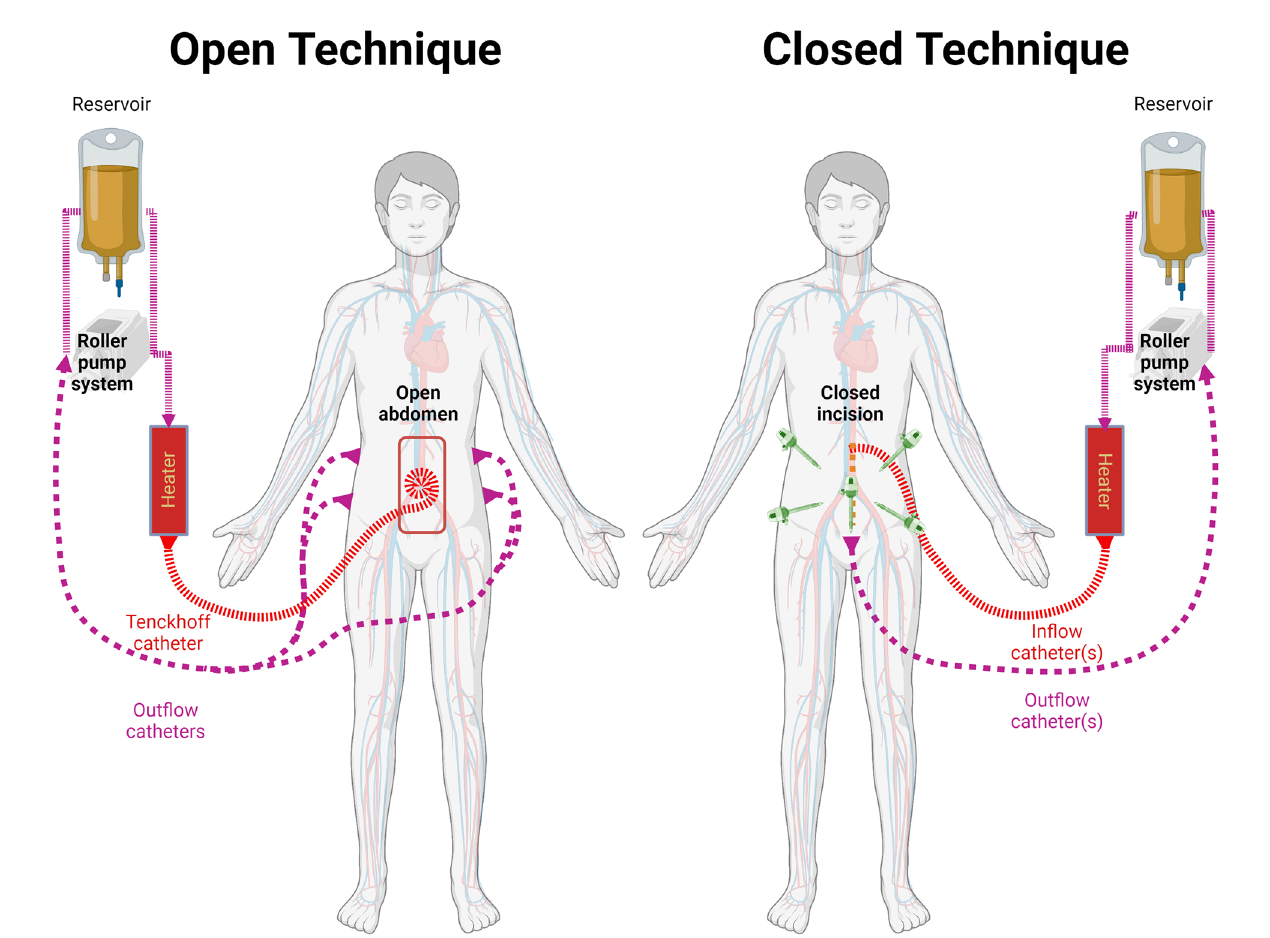
FIGURE 1 Methods for HIPEC administration. Both methods involve the use of a reservoir, roller pump system, heater, and connecting circuits. Temperature is monitored through the HIPEC procedure. Left: the open technique keeps the cavity open and retracts the wall to increase its fi lling capacity.Typically uses a Tenckhoff catheter for in fl ow and 2 catheters on each side for out fl ow as described by Sugarbaker et al. Right: the cavity is closed temporarily or de fi nitely for HIPEC. Variable number of cannulas are used. In recent years it has been used after laparoscopic cytoreductive